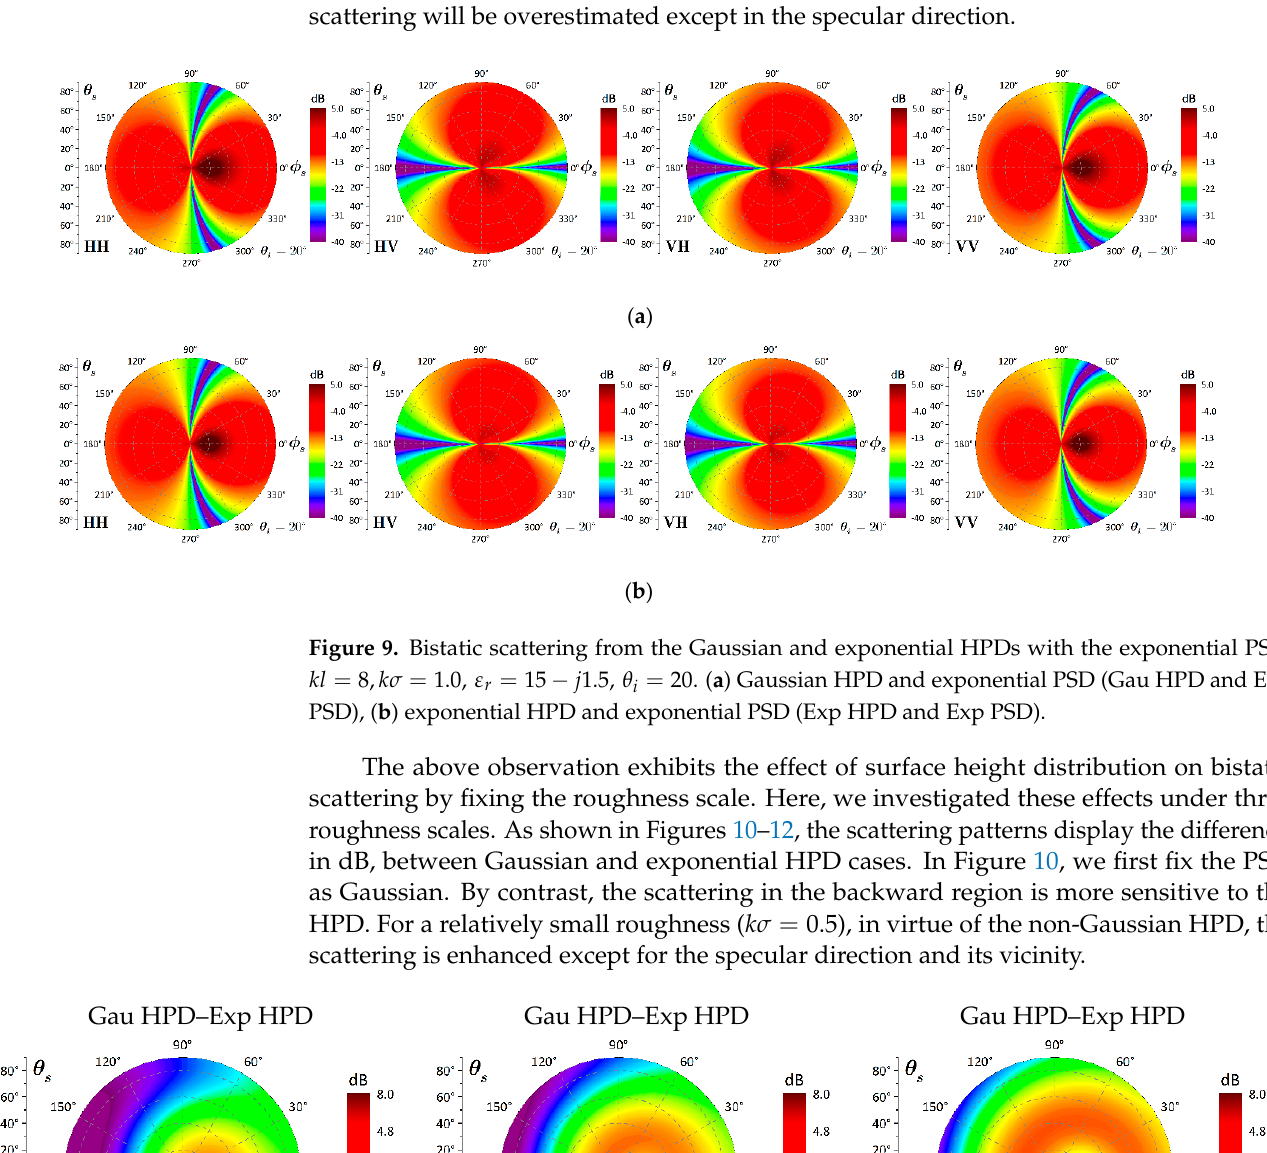
Figure 8. Bistatic scattering from the Gaussian and exponential HPDs with Gaussian PSD: . ( a ) Gaussian HPD and Gaussian PSD (Gau HPD and Gau PSD), ( b ) exponential HPD and Gaussian PSD (Exp HPD and Gau PSD).